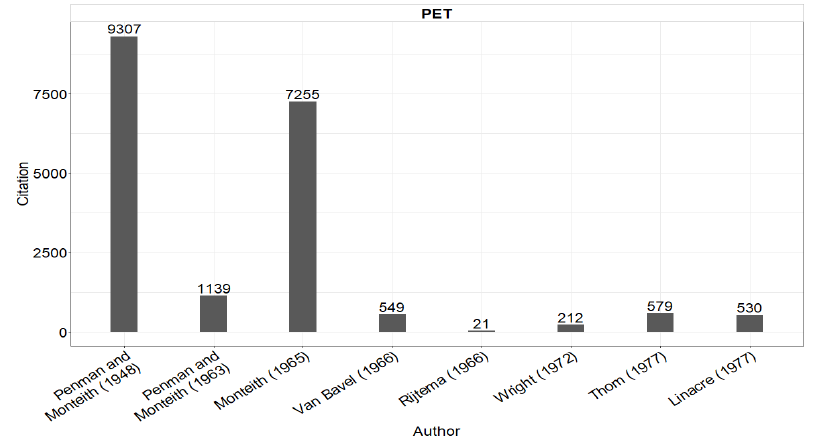
Figure 6. Citations of PET combination-based equations.